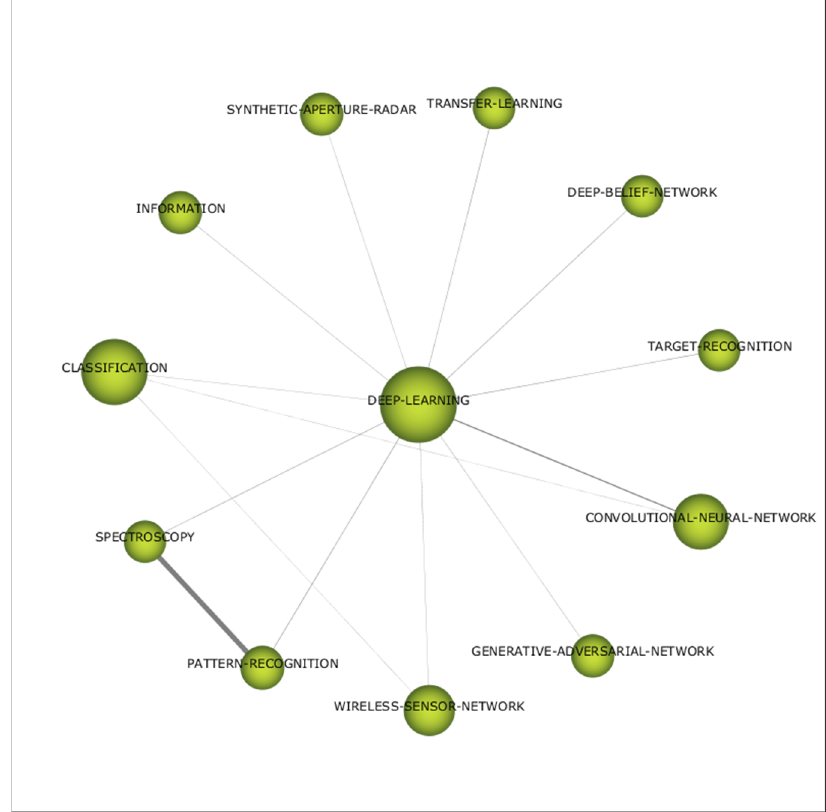
Figure 12. Category: ML and Opt techniques; From 2016; Theme: Deep learning.